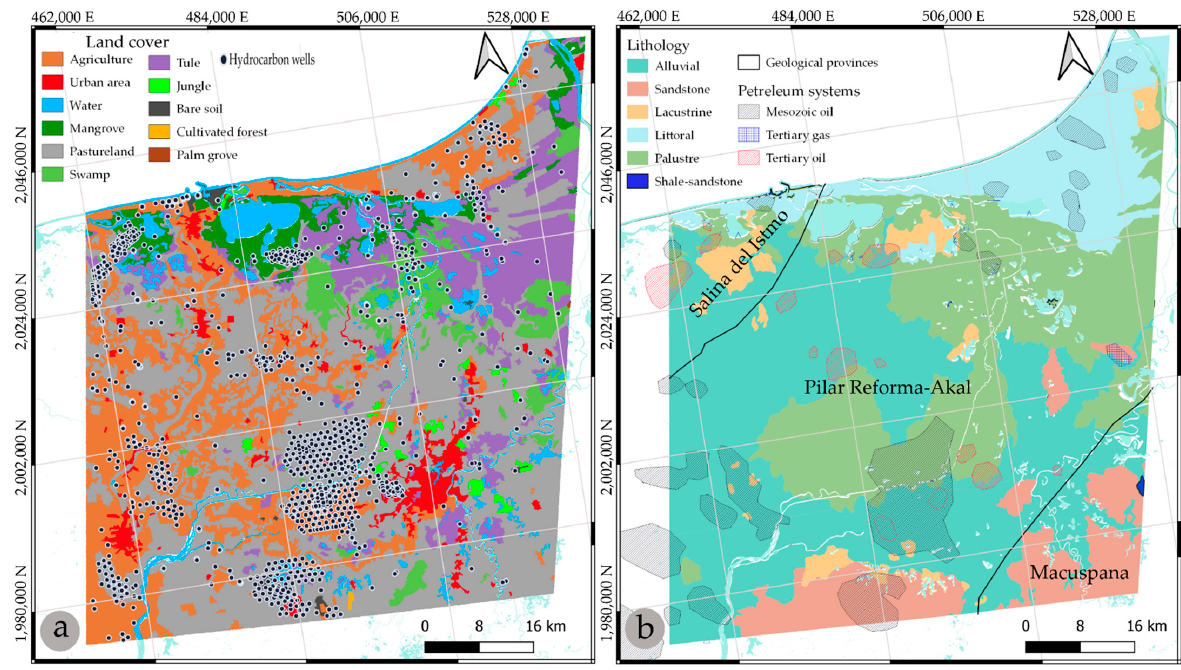
Figure 3. Physical-geographical characteristics of AOI; ( a ) land cover (INEGI [61] and distribution of hydrocarbon wells (IICNIH [62]). The area with the highest well density is located west of Villahermosa, with wells depth ranging between 1500 and 3500 m; ( b ) Lithology, geological provinces, distribution of the oil system, and its geological era [57,62].